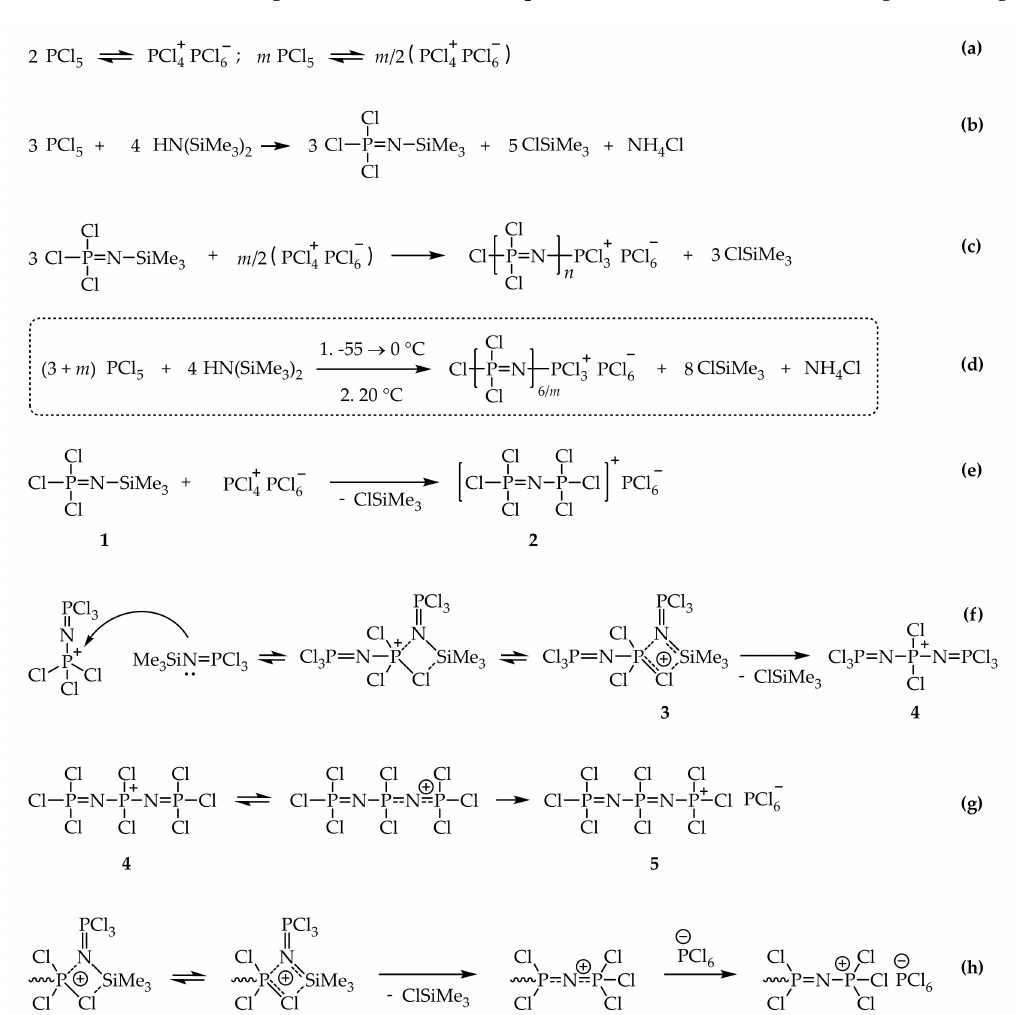
Figure 4. One-pot synthesis of oligodichlorophosphazene from PCl 5 and HMDS ( d ) via living cationic process and its mechanism: initiator formation ( a ), monomer formation ( b ), general scheme for polymerization ( c ), formation of active centers and initiation ( e – g ), chain growth ( h